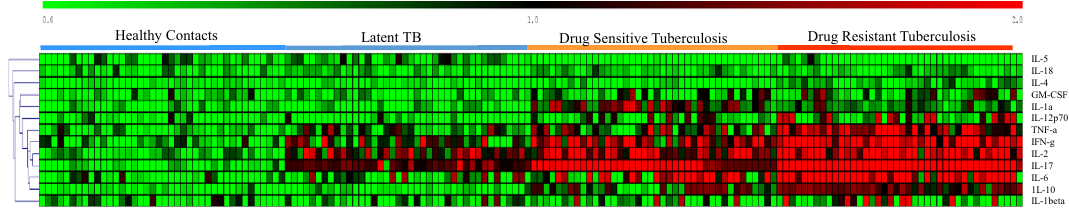
Figure 2. Heatmaps representing the measured cytokines and their hierarchical clustering across the TB disease spectrum by log 2 conversion and HC group mean